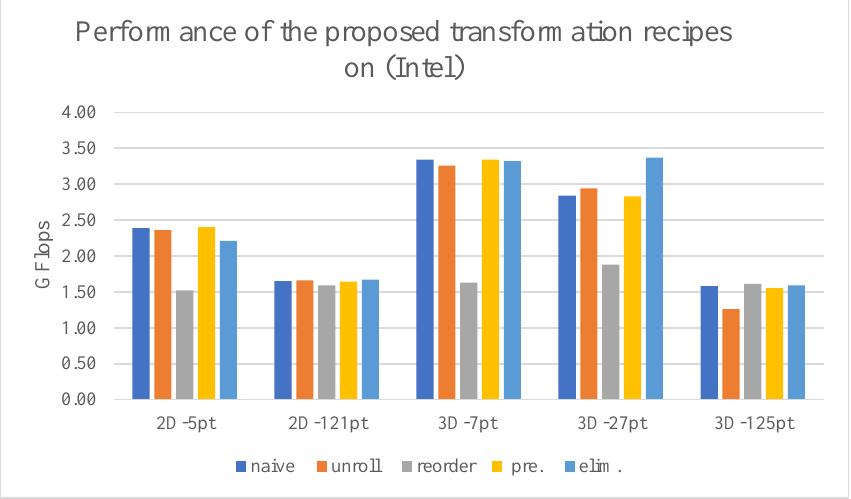
Figure 6. Experimental results of the proposed transformation recipes: (b) single recipe (Intel).